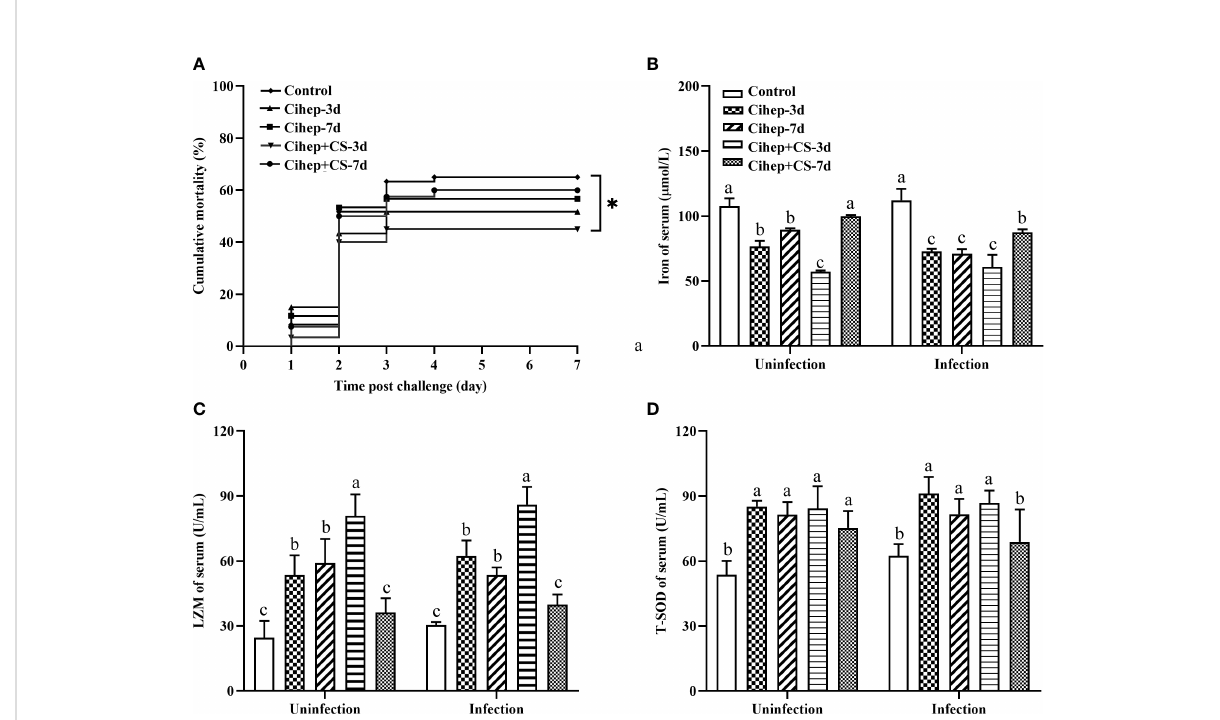
FIGURE 3 Mortality and Serum innate immune indexes statistics. (A) Fish in each group (n = 20) were challenged with 500 µL F. columnare (1 × 10 9 CFU/ mL), and death events in each group were monitored on the next 7 days. p values were calculated by Log-rank (Mantel – Cox) Test (* p< 0.05). (B-D) Serum innate immune indicators. Iron of serum (B) , LZM (C) and T-SOD (D) were measured by commercial kits (Nanjing Jiancheng Institute of Biological Engineering, Nanjing, China). Different small letters in each group (a, b, and c) denote signi fi cant variations suggested by the multifactorial ANOVA statistics (p <